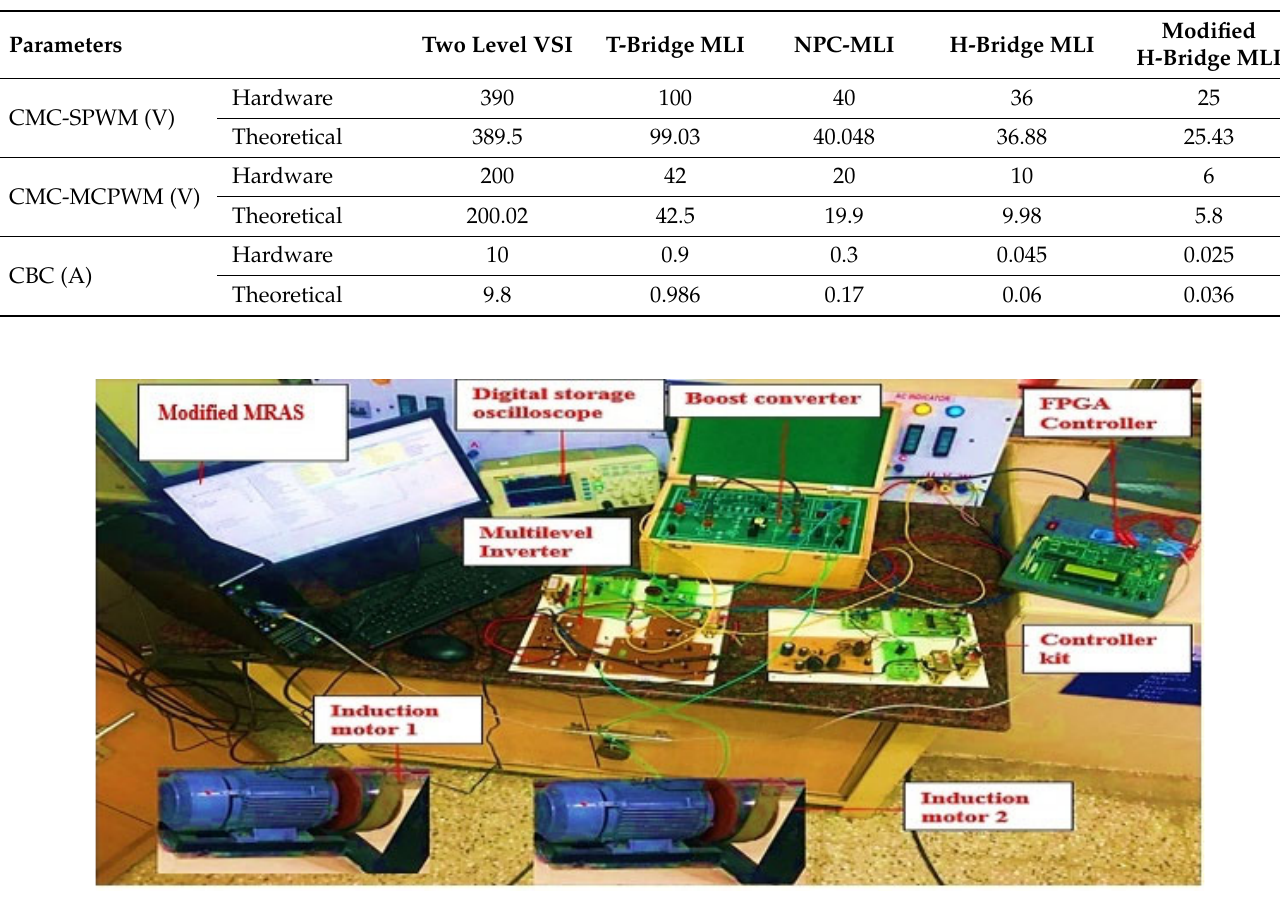
Figure 23. Hardware setup for proposed sensor less MLI fed parallel ‐ connected induction motor.